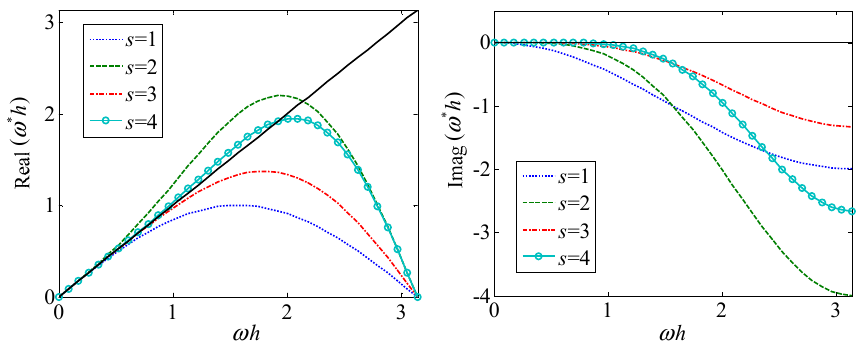
Figure 3. Plot of real and imaginary parts of the modified wavenumber for GBDF.